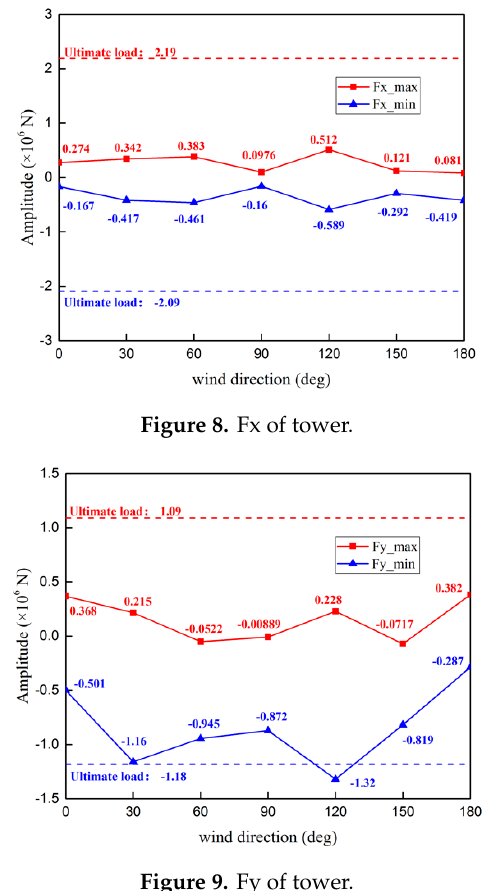
Figure 9. Fy of tower.